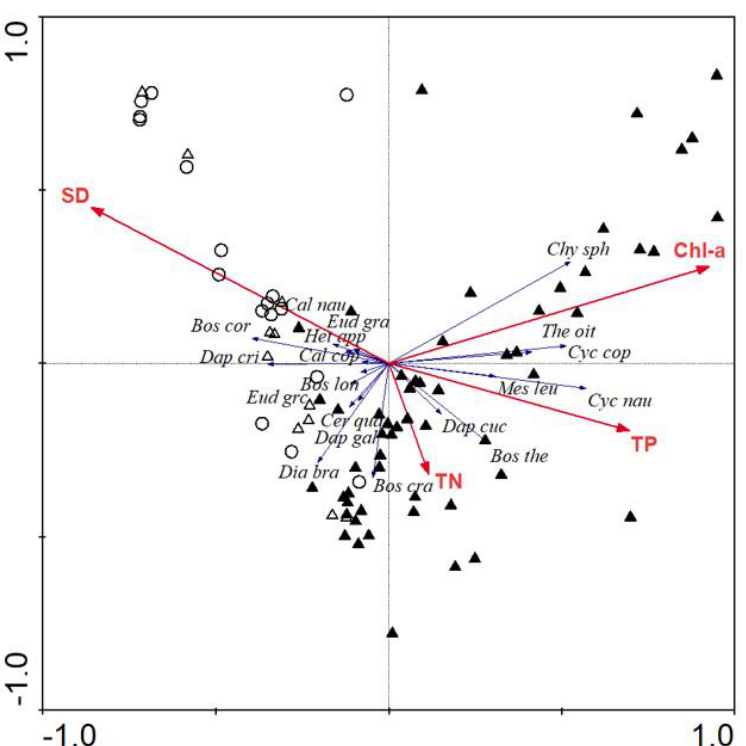
Figure 4. The distribution of the reference (circles) and non-reference lakes (triangles) and the Crus- tacea species (blue arrays) in the RDA space determined by four environmental variables (red ar- rays): Secchi disc visibility (SD), chlorophyll- a concentration (Chl – a ), total phosphorus (TP), total (red arrays): Secchi disc visibility (SD), chlorophyll- a concentration (Chl– a ), total phosphorus (TP), nitrogen (TN) and abundance of Crustacea species: Bos cor — Bosmina ( Eubosmina ) coregoni ; Bos the — total nitrogen (TN) and abundance of Crustacea species: Bos cor— Bosmina ( Eubosmina ) coregoni ; Bos the— Bosmina ( Eubosmina ) coregoni var. thersites ; Bos cra— Bosmina ( Eubosmina ) crassicornis